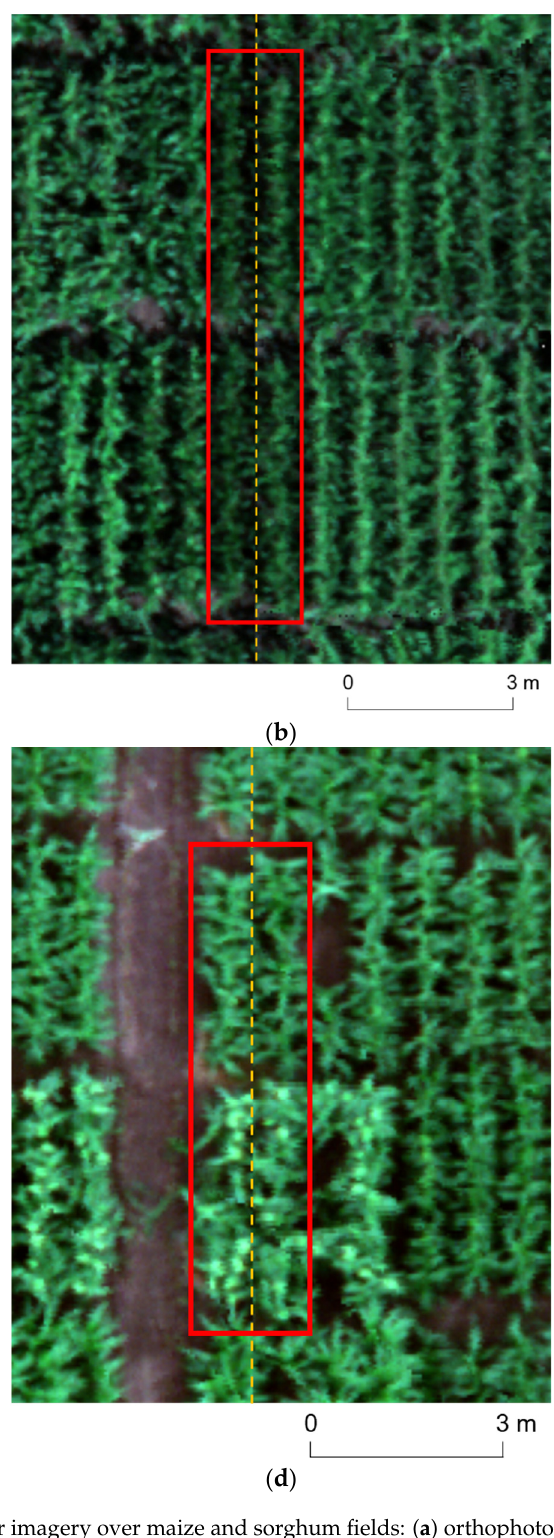
Figure 19. Generated orthophotos using UAV push-broom scanner imagery over maize and sorghum fields: ( a ) ortho- photo VII, ( b ) orthophoto VIII, ( c ) orthophoto IX, and ( d ) orthophoto X. Yellow dashed lines represent the seamlines and red boxes highlight the difference.